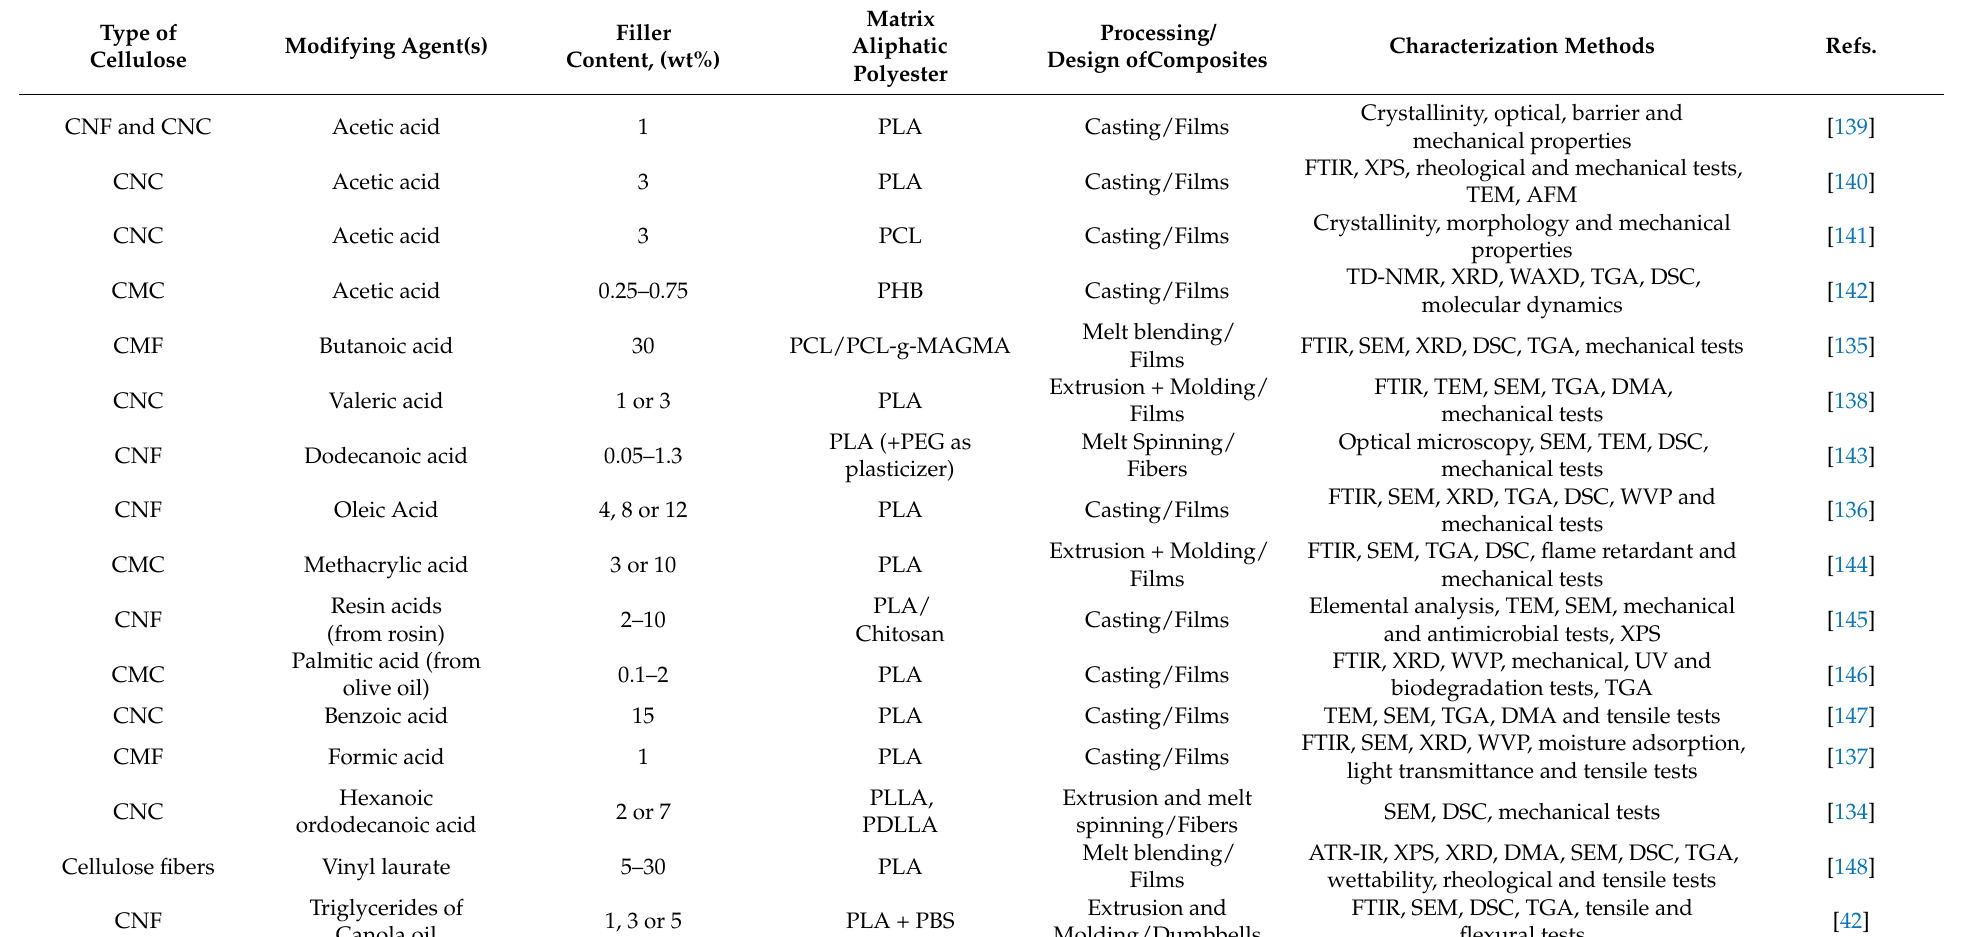
Table 4. Selected studies on covalent modification of cellulose micro- and nanomaterials via esterification and transesterification for the preparation of composites with aliphatic